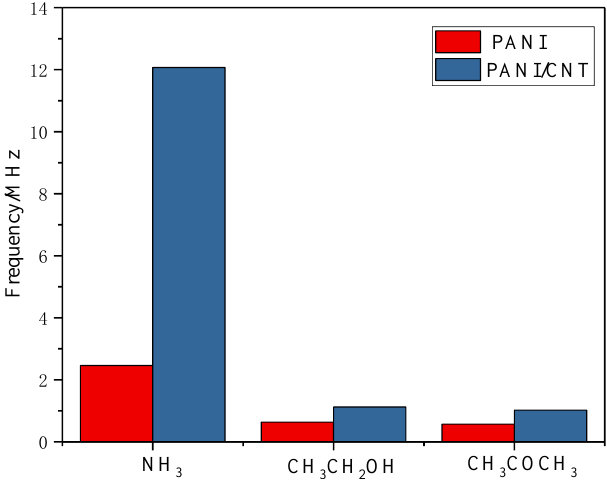
Figure 14. Variation of f 0 of different gases: It can be seen that in different gases, the variation of the PANI gas sensor is lower than that of PANI/CNT-related one In the 300-ppm NH 3 atmosphere, the variation of the resonant frequency of the PANI/CNT sensor reaches 12.070 MHz, which is 5.4 times as that of C 2 H 5 OH and 5.9 times of CH 3 COCH 3 .